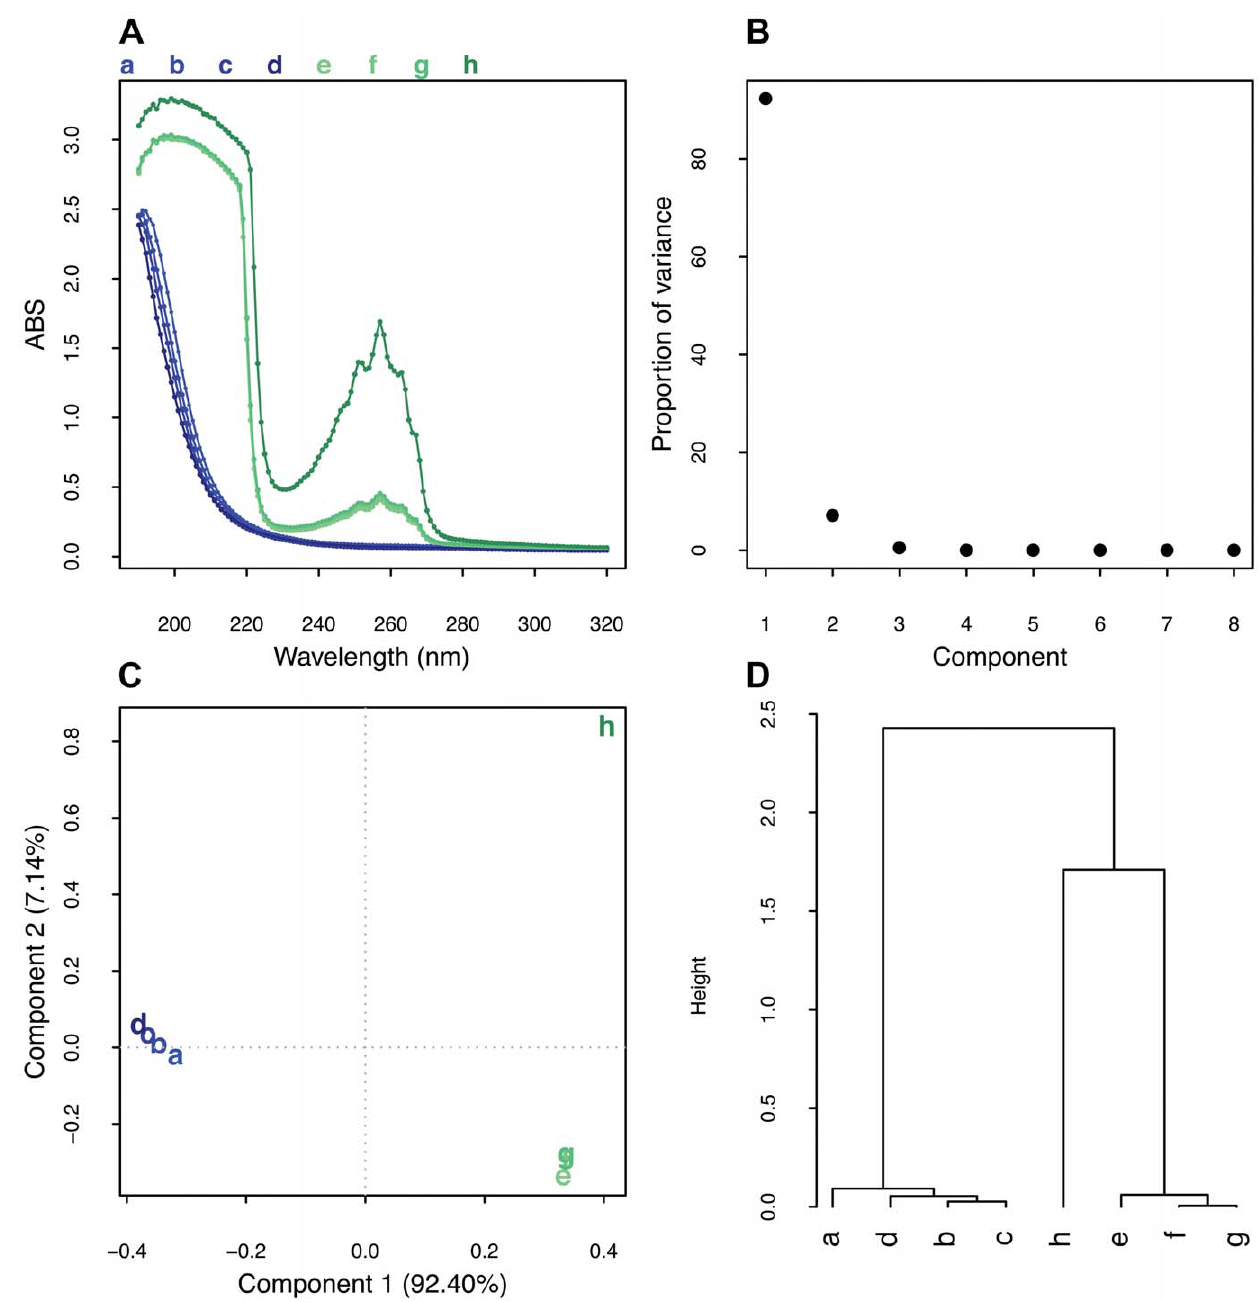
Figure 2. UV spectra, loading plot and Hierarchical cluster analysis of heparin samples. ( A ) Overlay of heparin samples scanning UV spectra. ( B ) Scree plot for PCA of the UV-scan spectra. ( C ) Component plot. ( D ) Hierarchical cluster analysis performed on the loading plot. Samples a–d represent pure heparin samples and e–h are the commercial contaminated heparins.